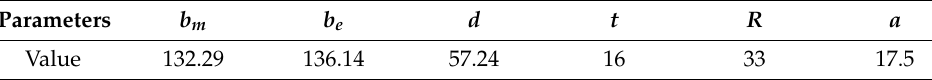
Figure 2. The relationship between 𝑅 (cid:2884) and the electron beam 𝛽 . Table 1. The geometric dimension of the 3-cell deflecting cavity. Table 1. The geometric dimension of the 3-cell deflecting